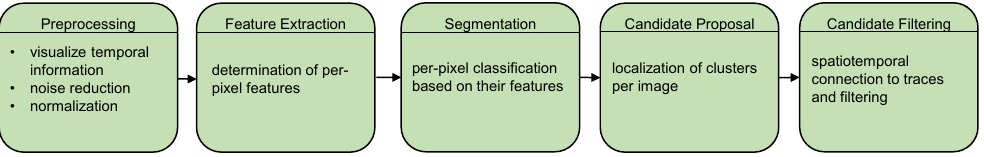
Figure 7. Meta-pipeline for the detection of nanoparticles in image series. Several approaches share similar steps in their specific pipelines